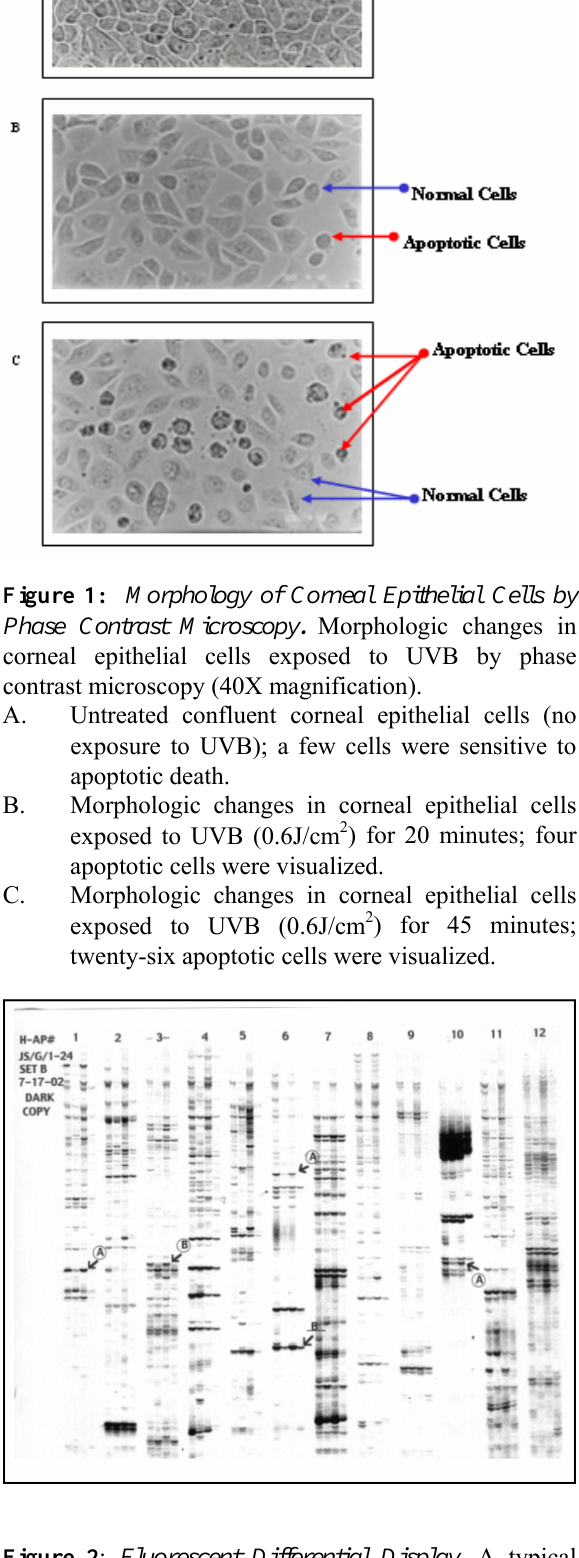
Figure 2 : Fluorescent Differential Display . A typical fluorescent image of differentially expressed cDNAs using a 6% denaturing polyacrylamide electrophoresis. Differentially expressed bands obtained from untreated